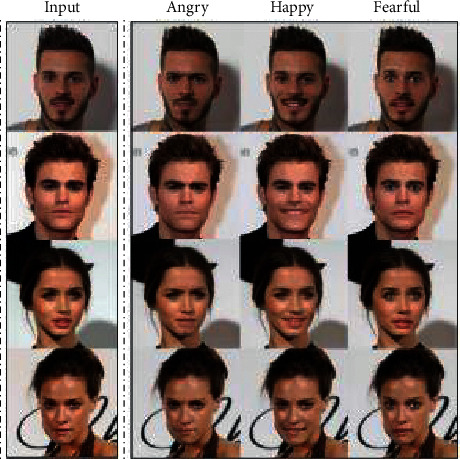
StarGAN generation image [71].